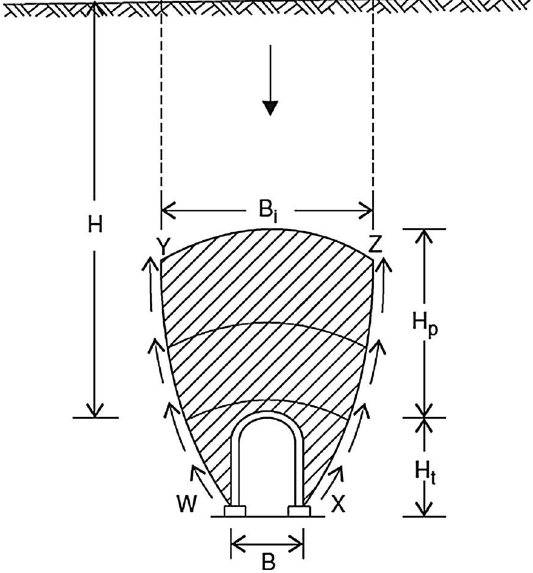
Figure 2. Development of loosened ground zone in response to tunnel construction. B and H t are the width and height of the tunnel, respectively, H p and B i are the height and width of the arching zone, respectively and H is the depth of the tunnel from the ground surface.